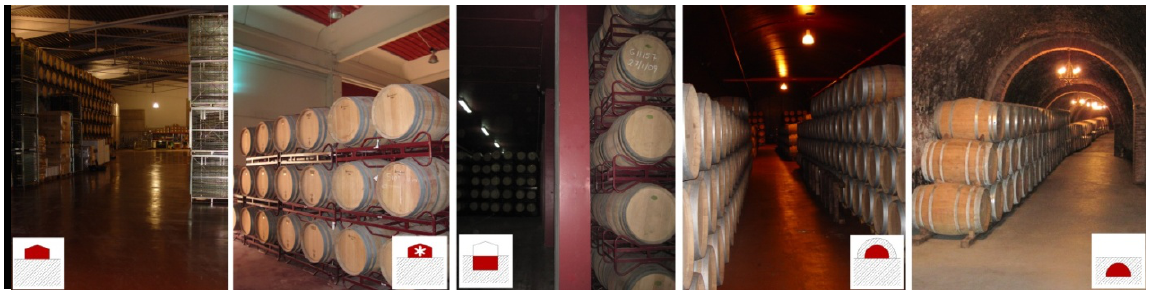
Figure 2. Close-ups of the interior of the selected constructions. From left to right, “aboveground without air-conditioning”, “aboveground with air-conditioning”, “basement”, “earth-sheltered” and